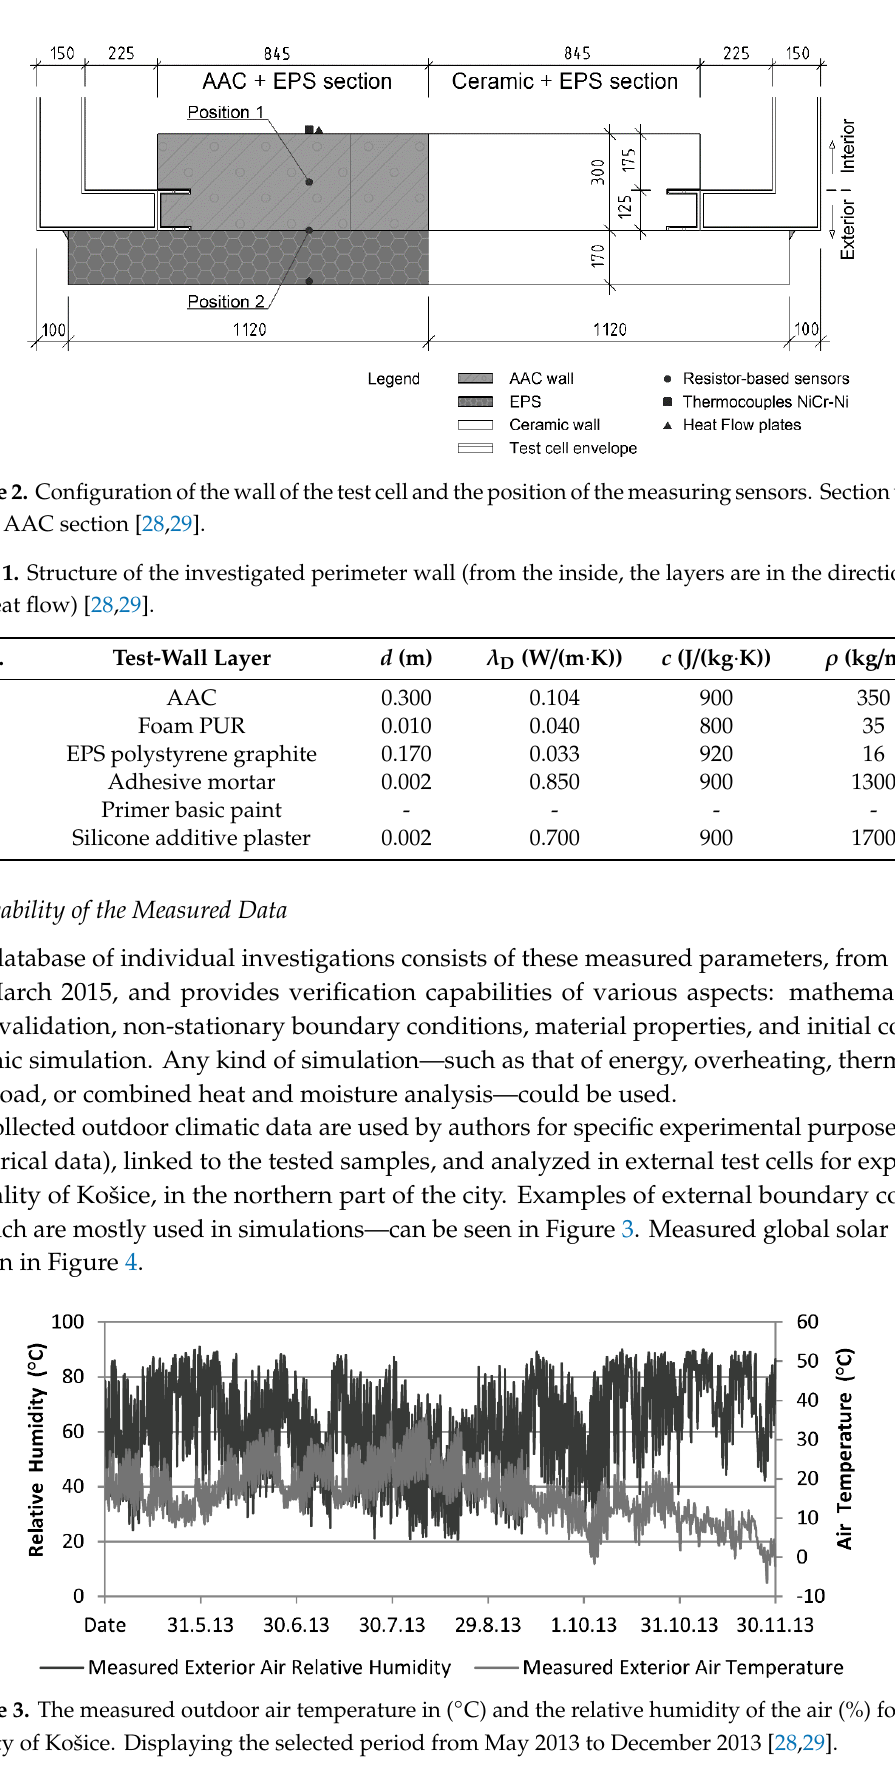
Figure 3. The measured outdoor air temperature in (°C) and the relative humidity of the air (%) for the locality of Košice. Displaying the selected period from May 2013 to December 2013 [28,29].